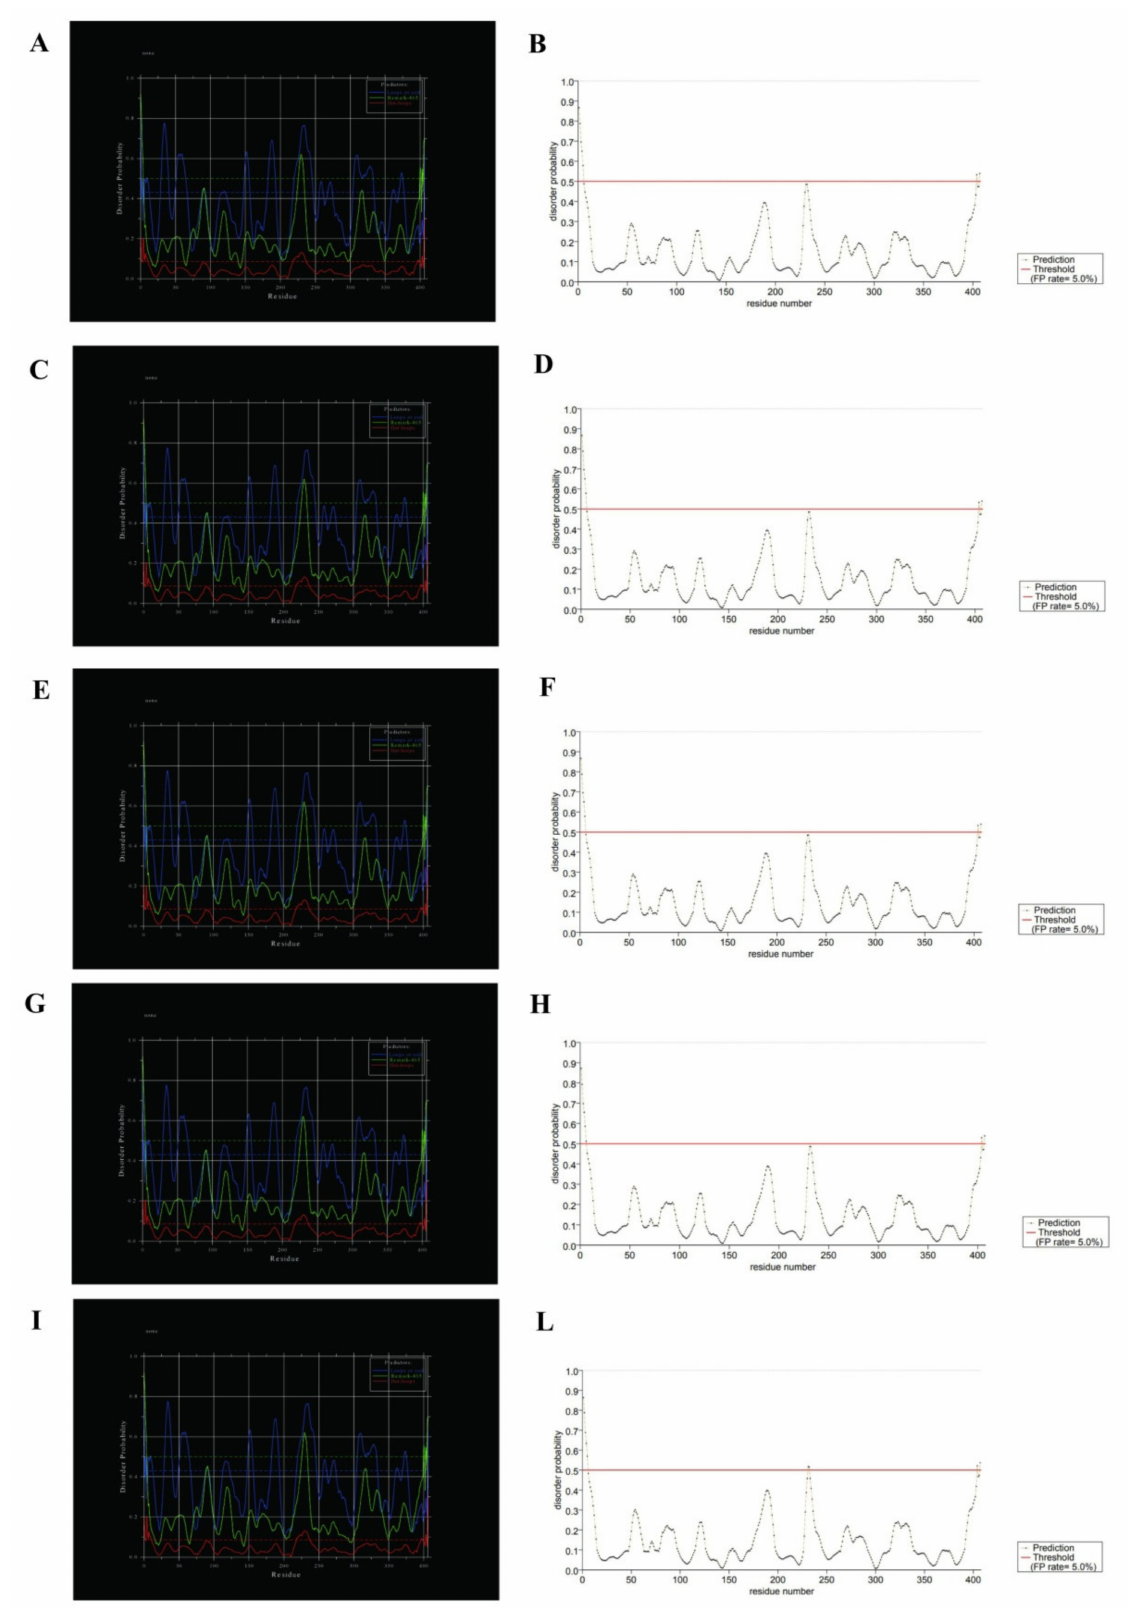
Figure 8. Disorder prediction for SecY variants by DisEMBL and PrDOS programs. To the left SecY1 ( A ), SecY6 ( C ), SecY9 ( E ), SecY33 ( G ), and SecY52 ( I ) was analyzed through DisEMBL program; to the right SecY1 ( B ), SecY6 ( D ), SecY9 ( F ), SecY33 ( H ), and SecY52 ( L ) was analyzed through